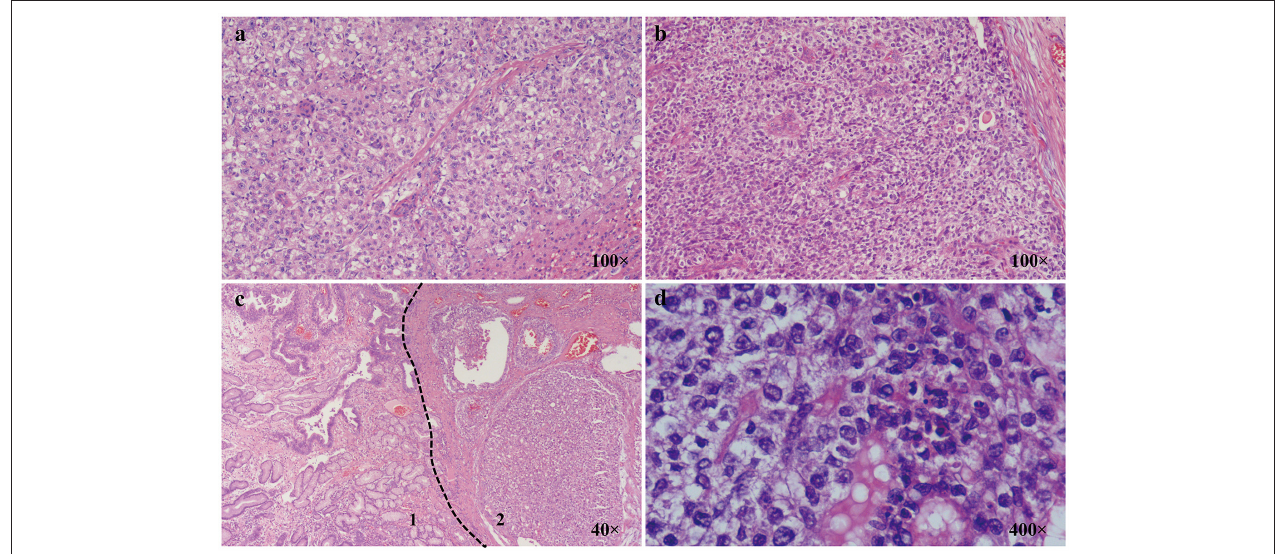
FIGURE 1 | Characteristics of AFP-GI under a light microscope. (a) Classic primary hepatic carcinoma (100 × ); (b) Classic hepatoid adenocarcinoma (100 × ); (c) 1. Zone of adenocarcinoma with moderately differentiation; 2. Zone of adenocarcinoma with hepatoid differentiation (40 × ); (d) Zone of adenocarcinoma with hepatoid differentiation is composed of cells with round nuclei, coarse chromatin, obvious nucleoli, and clear cytoplasm (400 ×